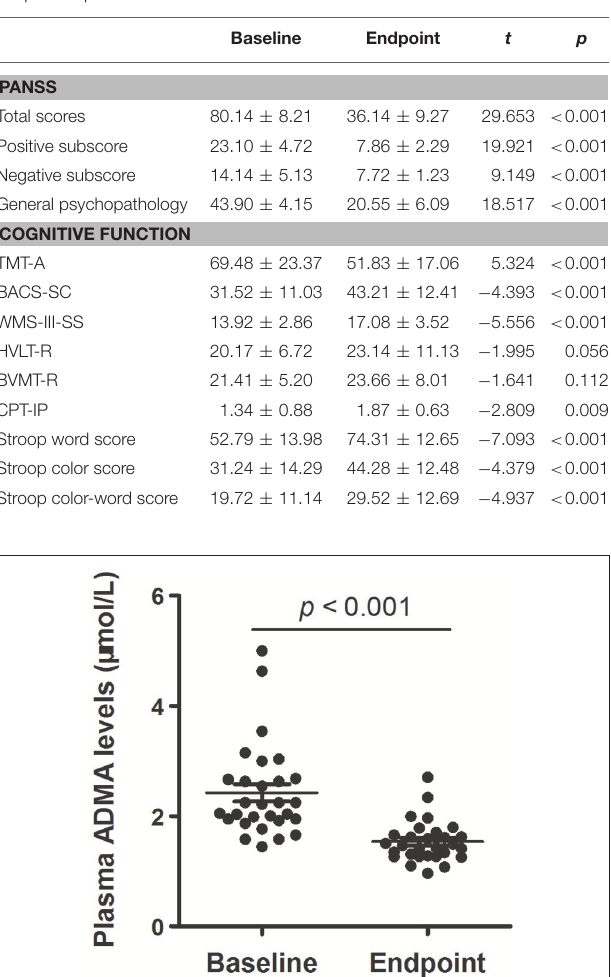
TABLE 2 | Comparison of PANSS and cognitive test scores between baseline and endpoint in patients.